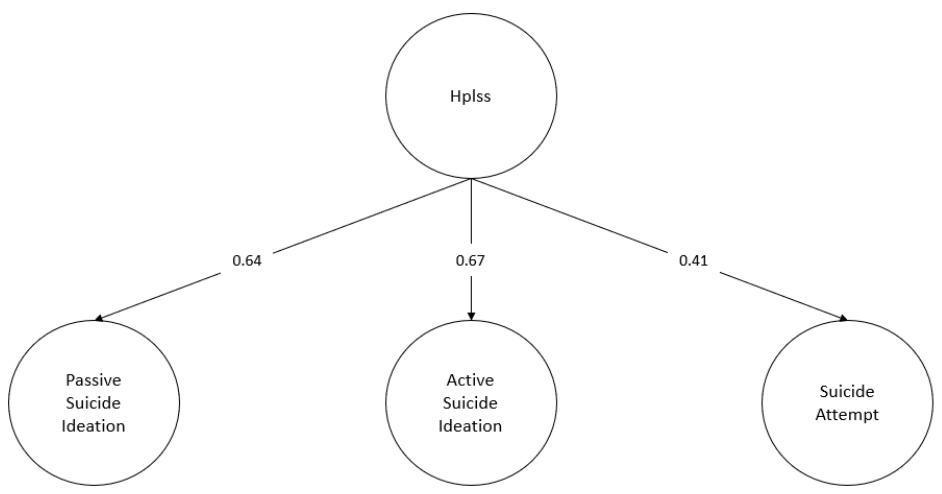
Figure 3. Structural model: occurrence. Hplss: hopelessness. Standardised regression coefficients. For the sake of clarity, observable indicators for each latent factor considered in the model are omitted from the diagram. Likewise, the interfactor correlations between the suicide severity factors were omitted.